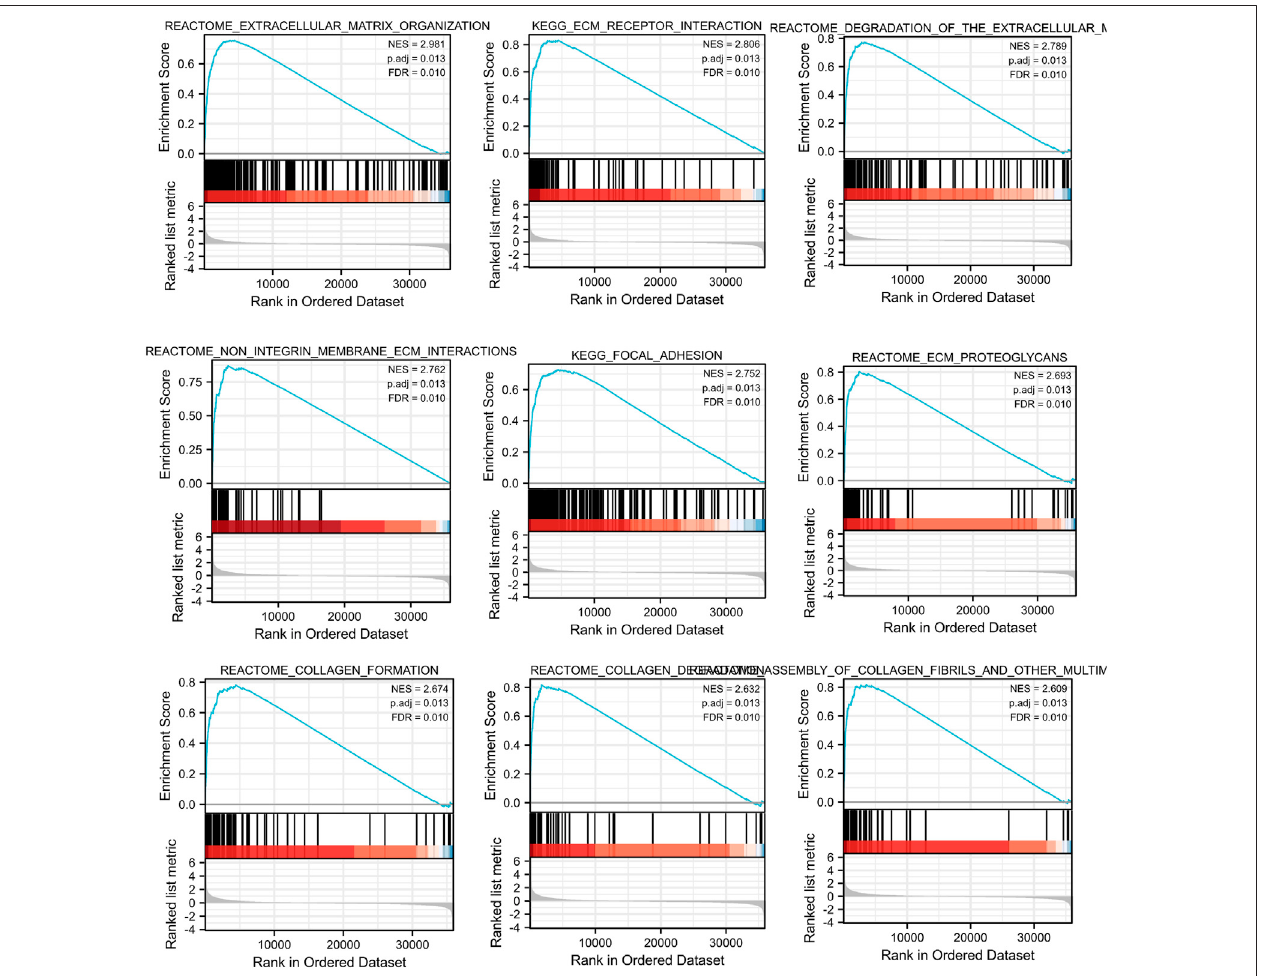
FIGURE 5 | Top 9 signi fi cant results most positively associated with INHBA , including Reactome pathways and KEGG pathways.